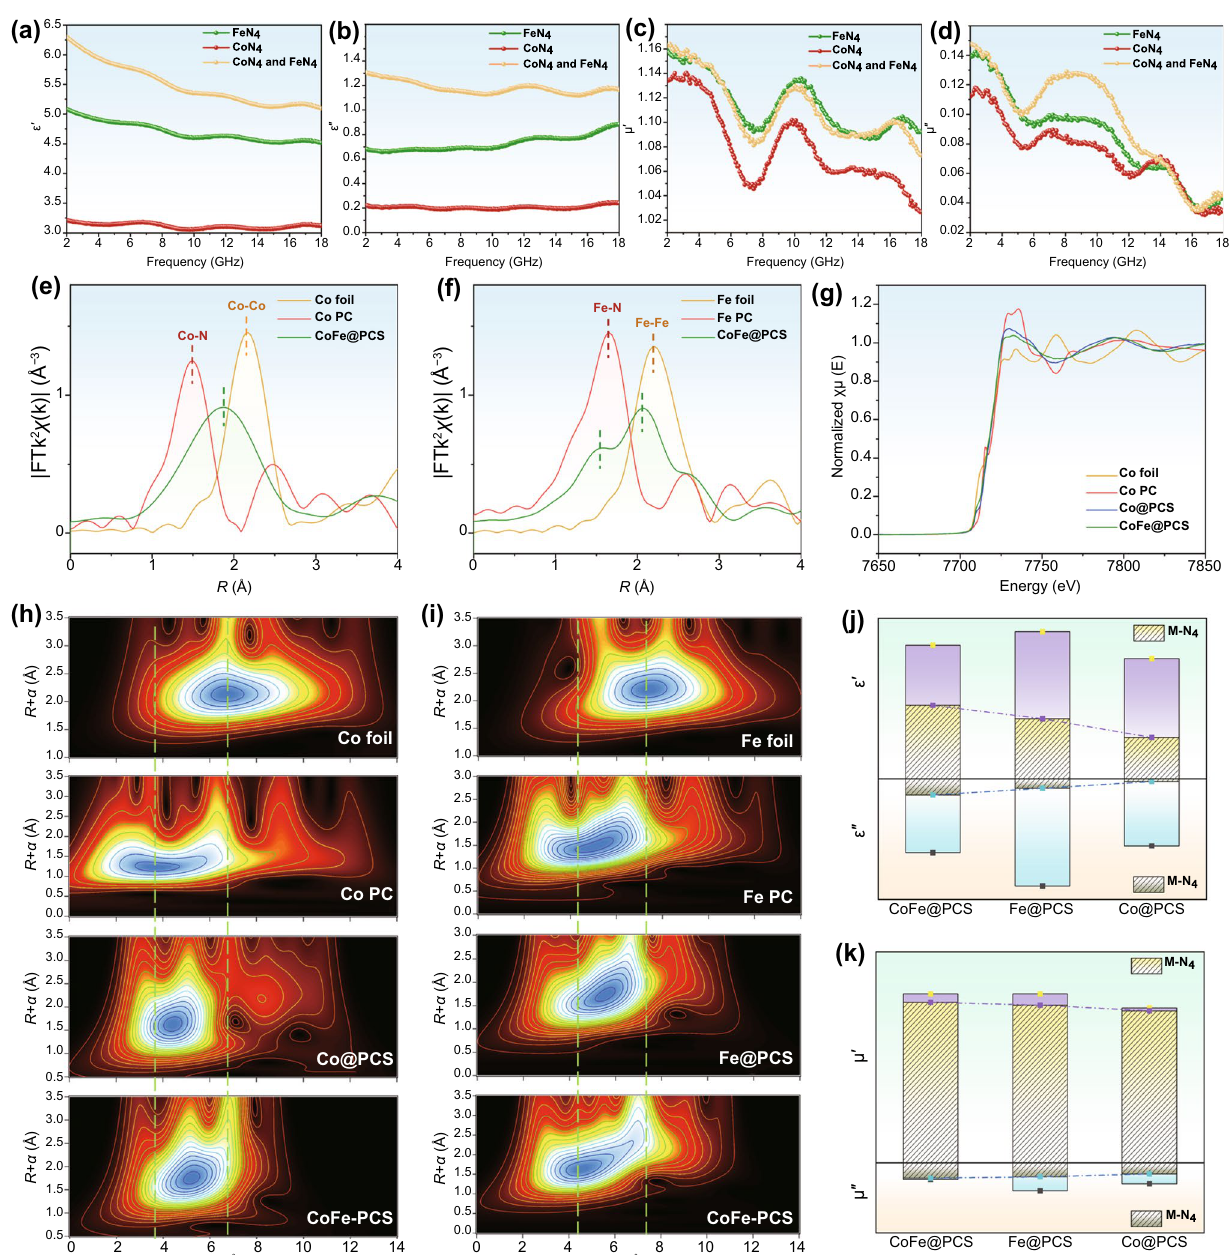
Fig. 4 Analyses of Co-Fe interaction in CoFe@PCS. a The real part and b imaginary part of permittivity. c Real part and d ) imaginary part of permeability for Fe–N 4 , Co–N 4 , CoFe–N 4 in Fe@PCS, Co@PCS, and CoFe@PCS. e K-edge EXAFS spectra for Co foil, Co PC, and CoFe@ PCS. f K-edge EXAFS spectra for Fe foil, Fe PC, and CoFe@PCS. g Experimental XANES spectra. h‑i Wavelet transform for the k 2 -weighted EXAFS signals. j‑k The permittivity and permeability of Fe–N 4 , Co–N 4 , and CoFe–N 4 in Fe@PCS, Co@PCS, and